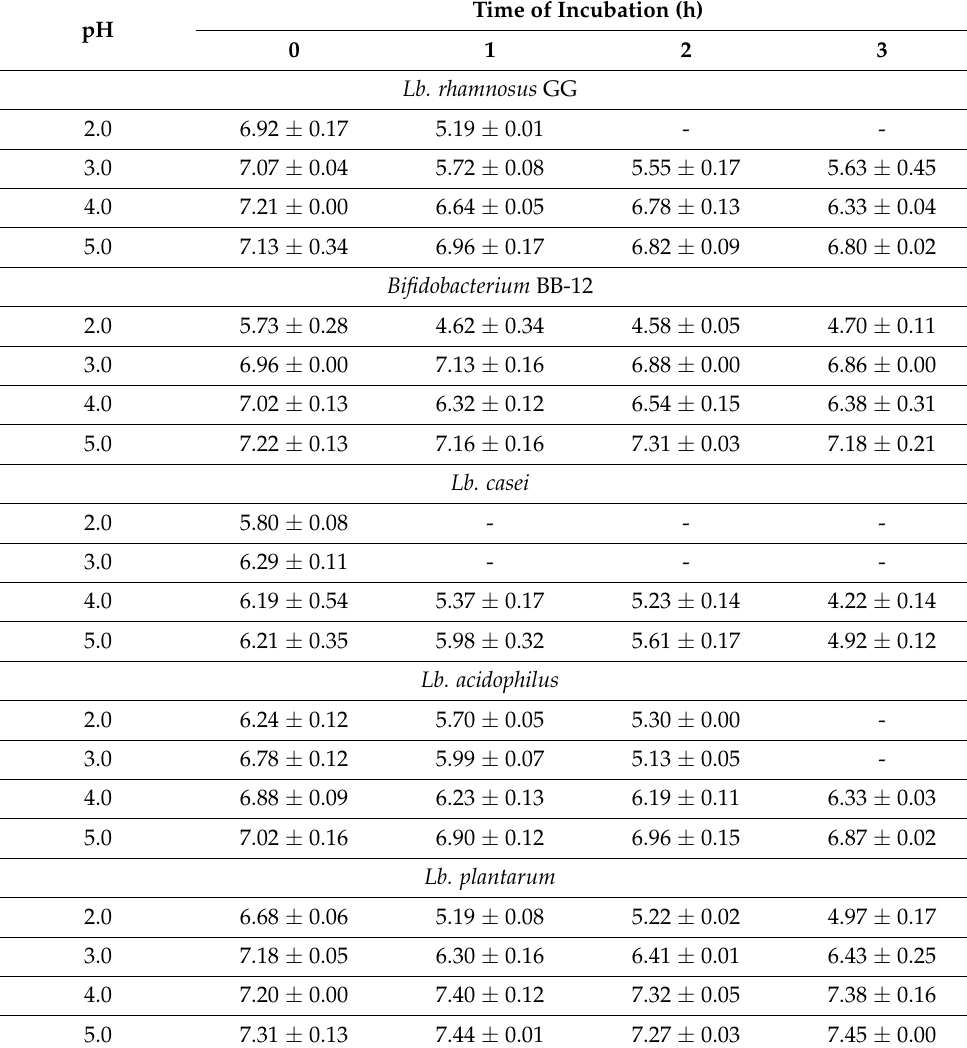
Table 3. Growth of commercial probiotic strains (log CFU mL − 1 ± SD) in the food matrix under simulated condition of the gastric